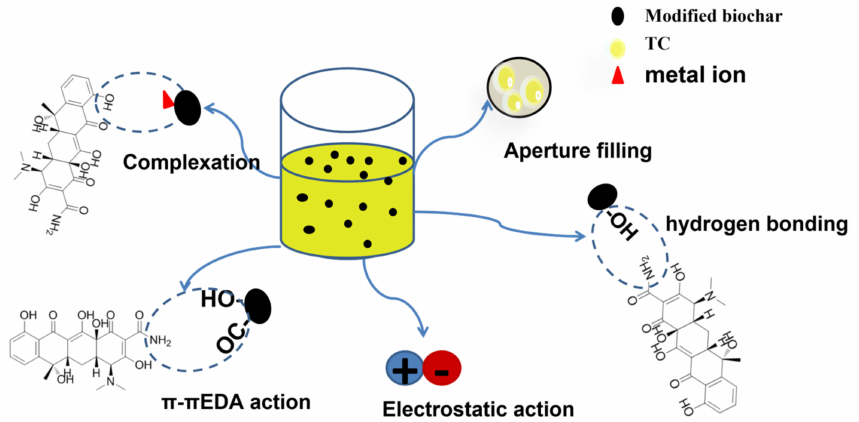
Figure 11. Mechanism diagram of TC adsorption on activated crab shell